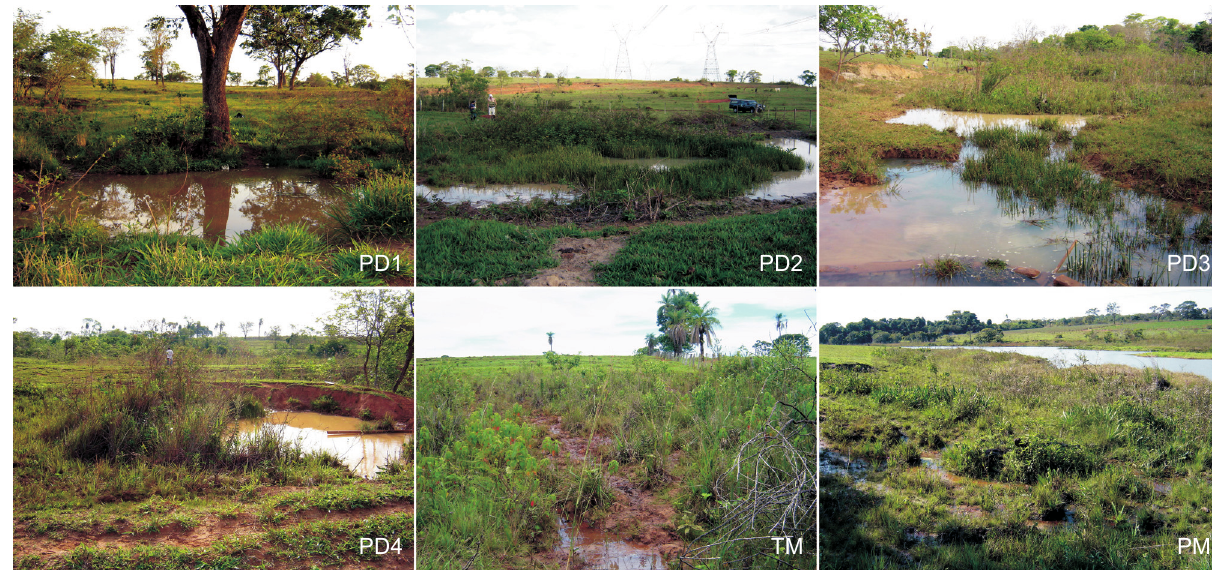
Figure 1. Breeding ponds sampled in Icém, São Paulo. (PD) Permanent dams, (TM) temporary marsh, (PM) permanent marsh.